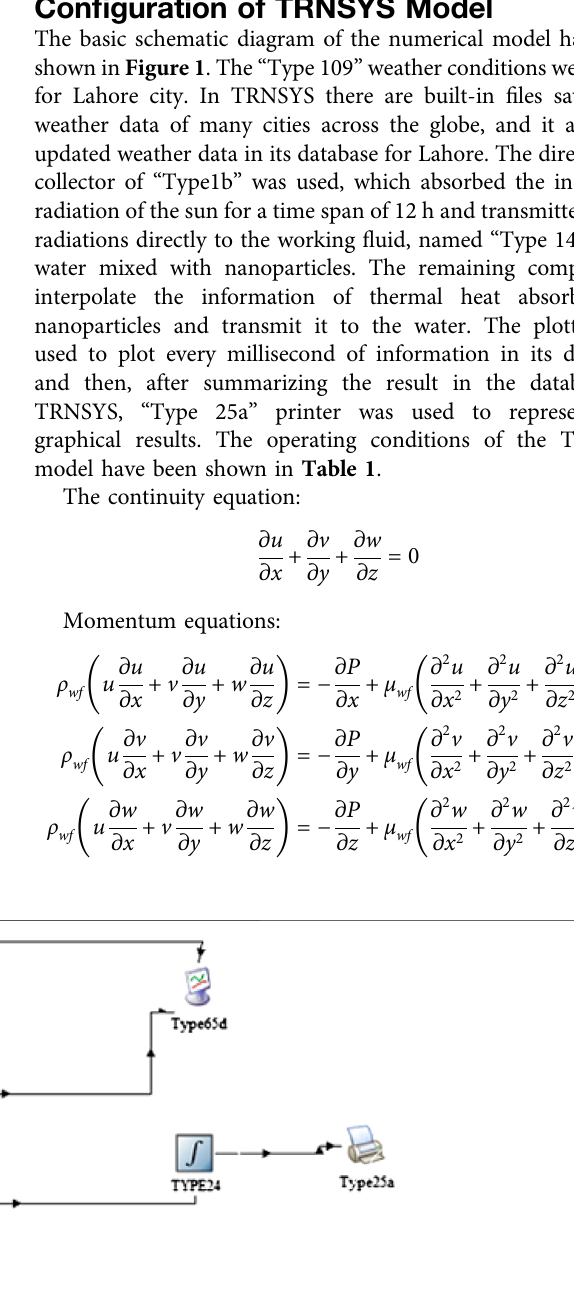
Frontiers in Materials |